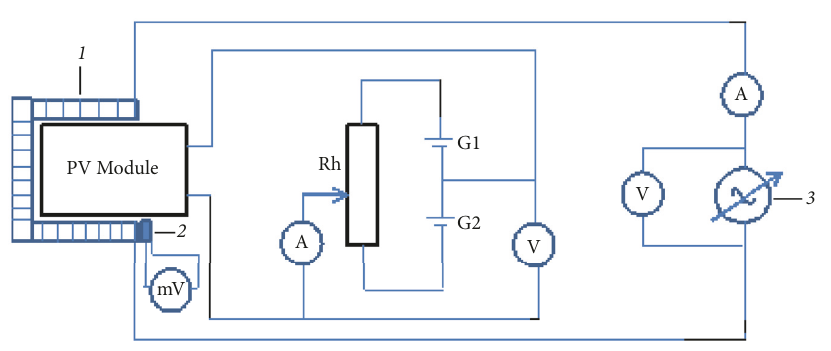
Figure 2: Experimental setup ((1) inductance in U form; (2) probe; (3) autotransformer.).